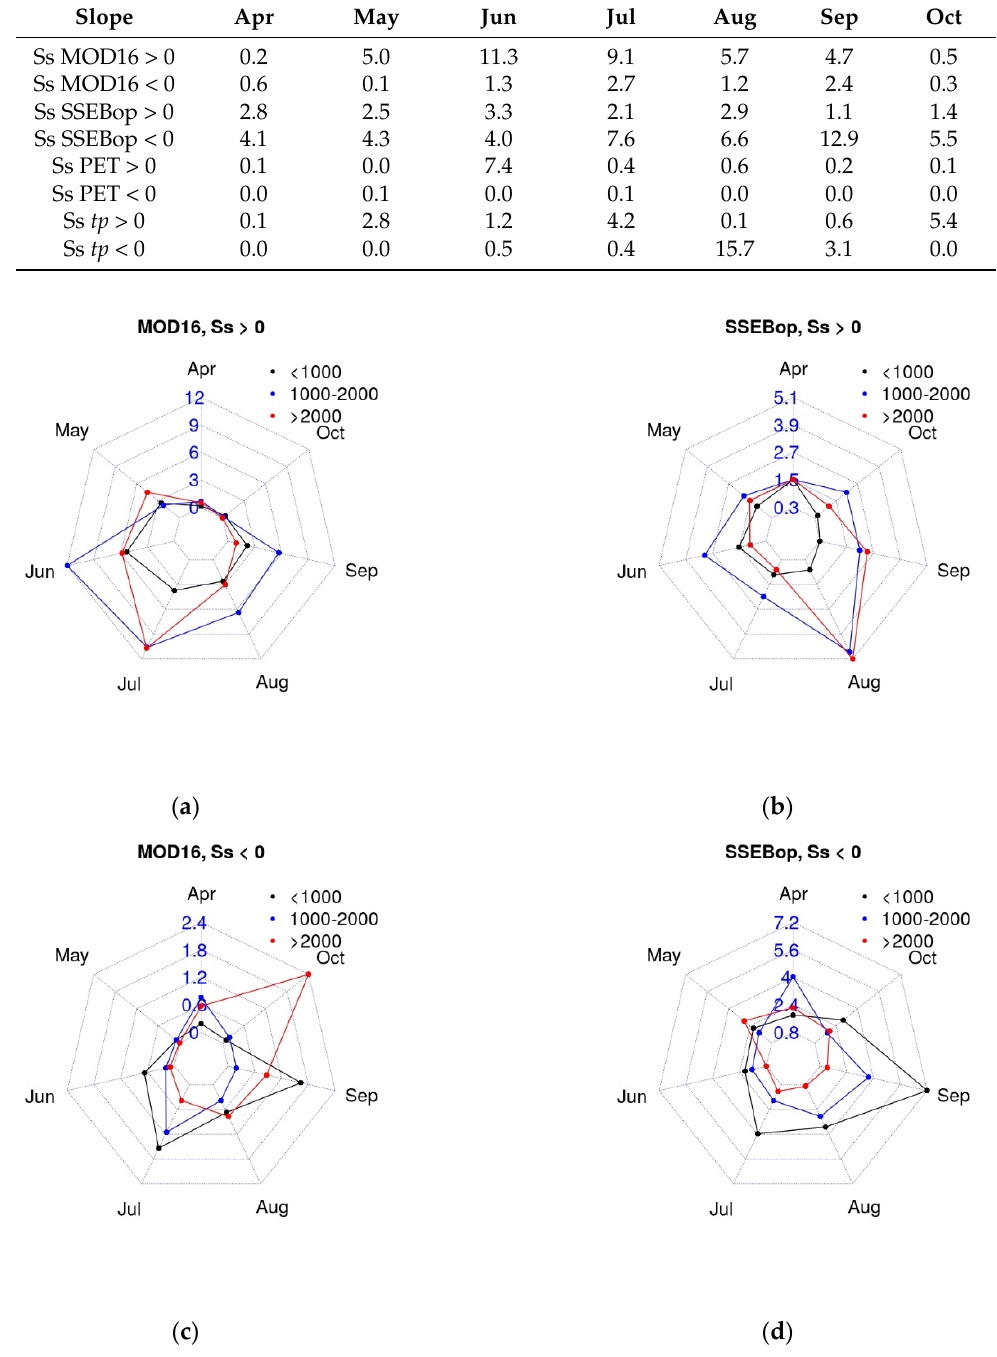
Figure 5. Percentage of area (blue numbers) in each elevation range with a positive ( a , b ) or negative ( c , d ) slope of the trend (Ss) of monthly ET from MOD16 and SSEBop, at 5% significance level. Black, blue, and red lines represent the three elevation classes.